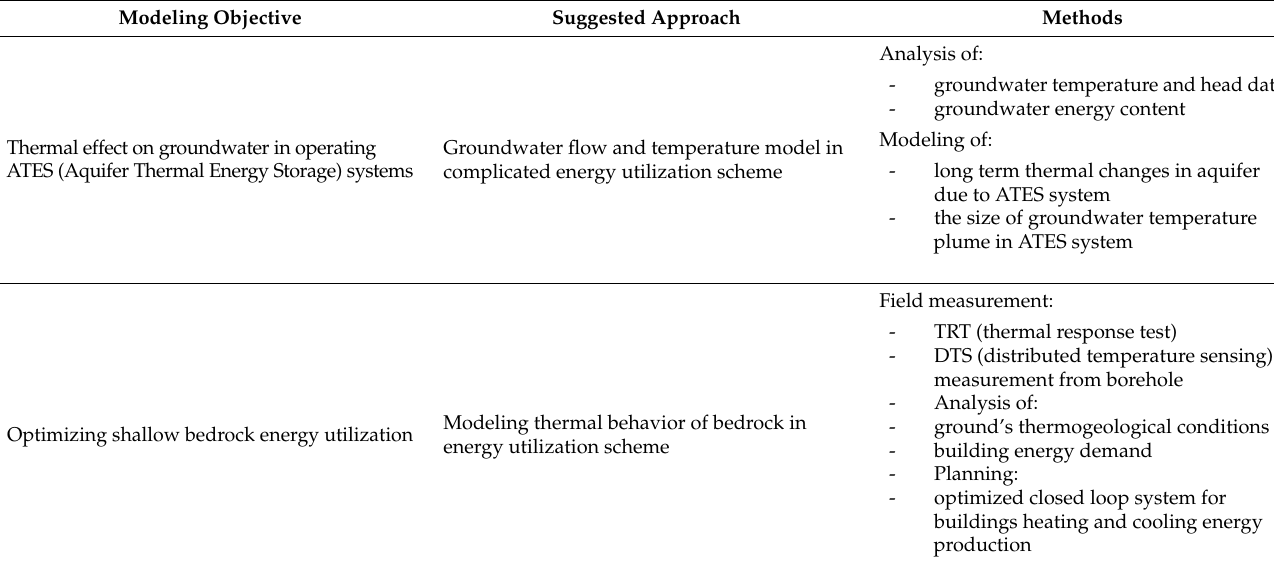
Table 6. Shallow geothermal energy evaluation.